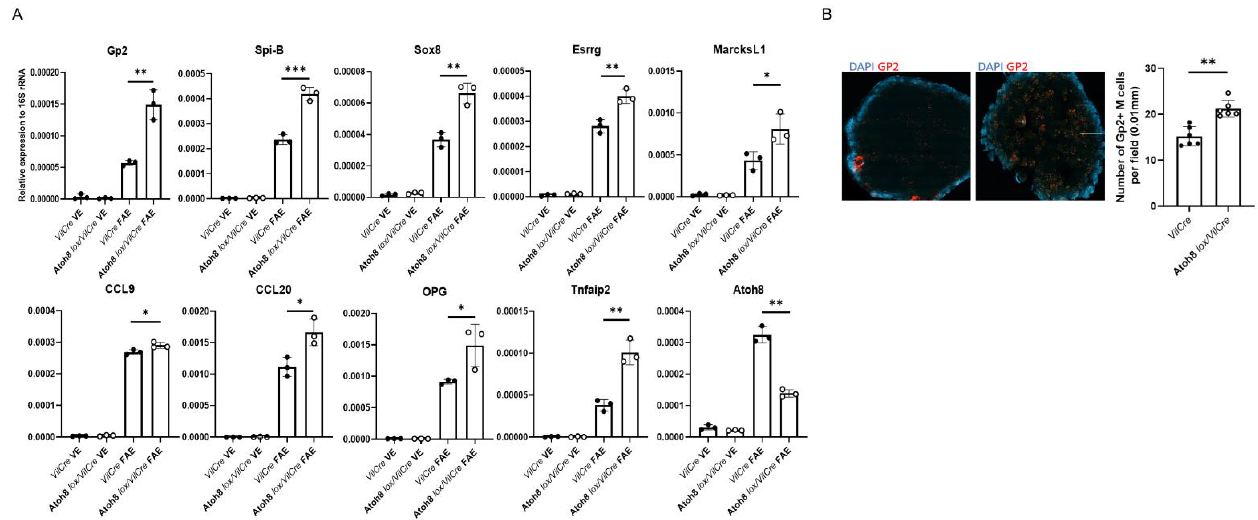
Figure 2. The loss of Atoh8 increases the number of mature M cells in the FAE. ( A ) qPCR analysis of M cell-associated genes in the FAE and VE of Atoh8 lox/VilCre and VilCre mice. ***, p < 0.005, *, p < 0.05 **, p < 0.01; n.s., not significant; unpaired two-tailed Student’s t -test, n = 3. ( B ) Whole-mount immunostaining of PPs from VilCre and Atoh8 lox/VilCre mice. The number of GP2+ M cells per field of FAE (0.01 mm2) was compared between them ( n = 8). Scale bars, 200 μm.